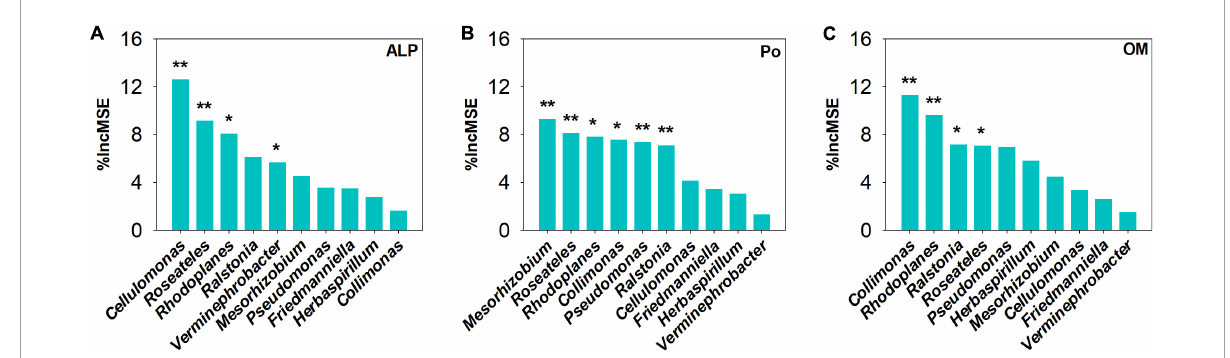
FIGURE7 Random Forest analysis to identify the main predictors of keystone taxa on (A) alkaline phosphatases (ALP), (B) organophosphorus (Po), and (C) orthophosphate monoester. The mean decrease in accuracy (%IncMSE) was used to indicate the relative importance of each variable for predicting the soil’s total P concentration. *Correlation is significant at the 0.05 level; **correlation is significant at the 0.01 level.